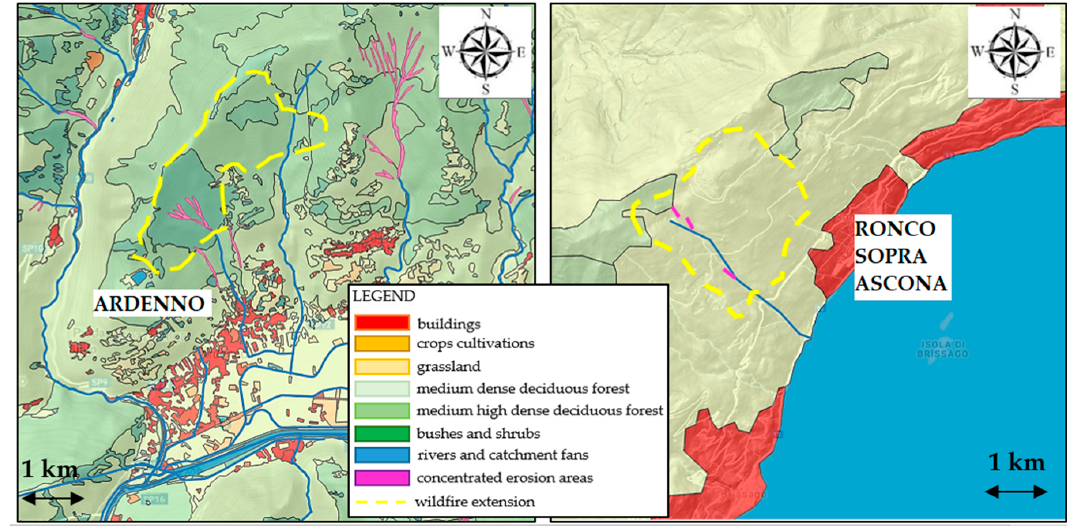
Figure 4. Land use representation according to the Corine Land Cover Classification [36] and susceptible hydrogeological areas characterizing the Ardenno and Ronco sopra Ascona municipalities.